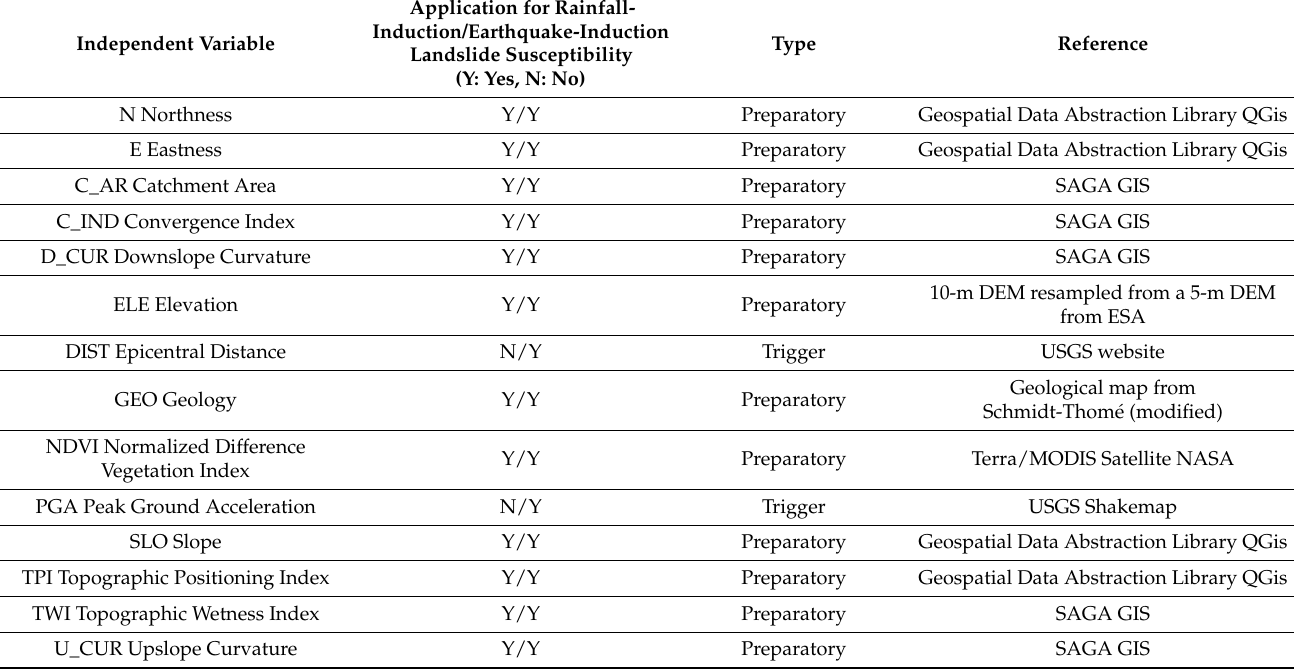
Table 3. Independent variables used to model rainfall- and earthquake-induced